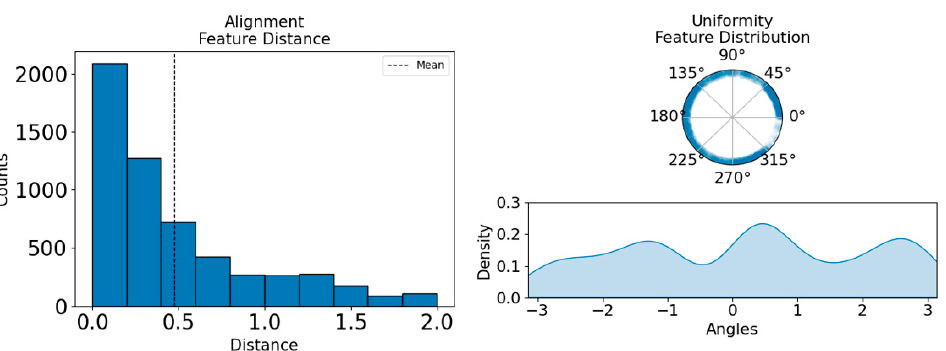
Figure 4. The generative method, PointCapsNet.